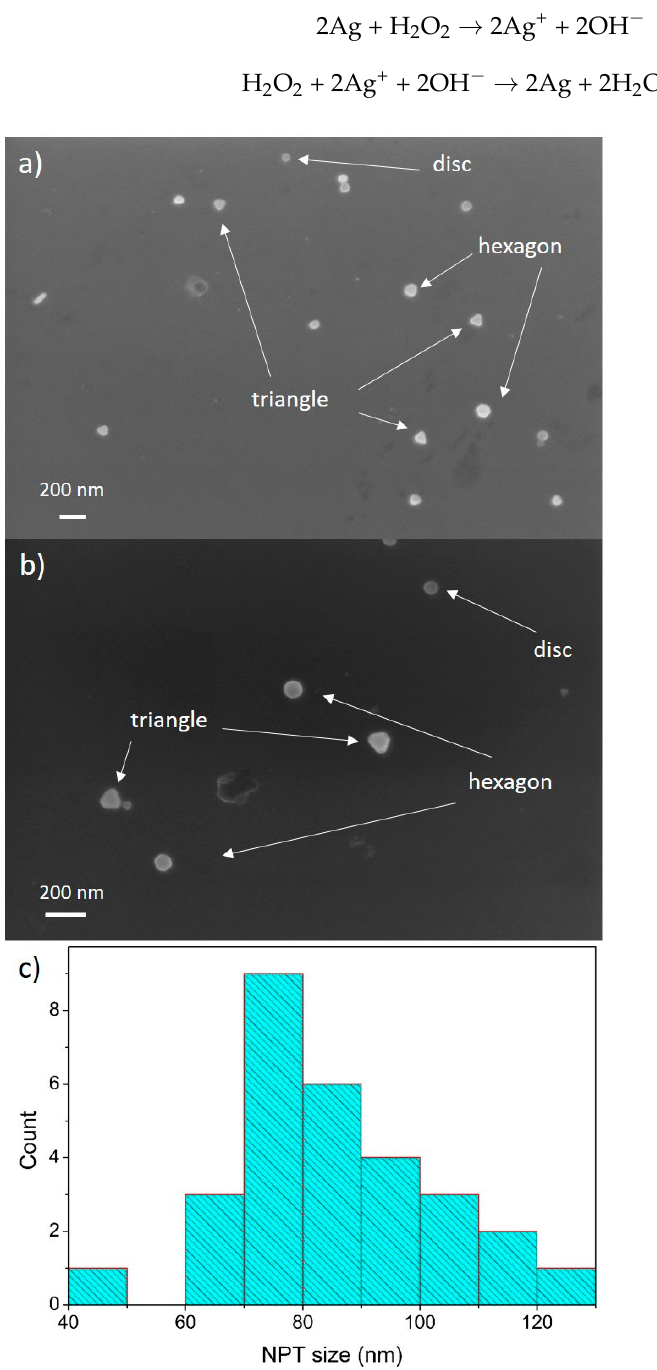
Figure 3 . ( a , b ) SEM images of Ag NPTs; ( c ) size distribution of Ag NPTs obtained from SEM image analysis .